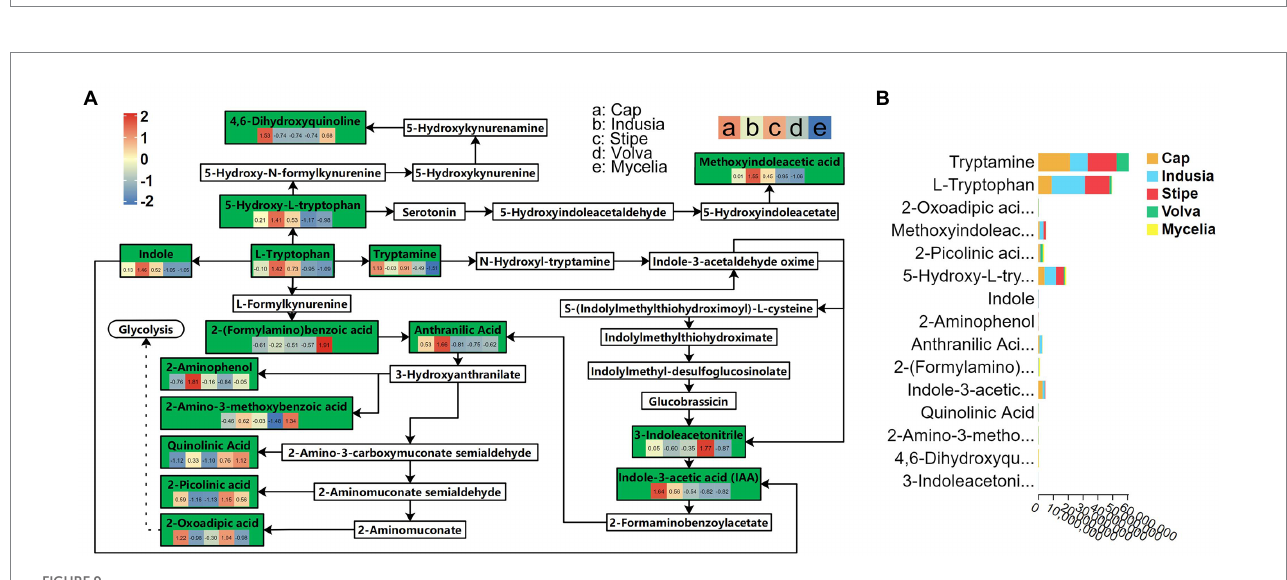
FIGURE 9 Tryptophan metabolism pathway (ko00380) in five DI tissues. (A) The boxes represent metabolites involved in the pathway. Green boxes represent the detected metabolites, and white boxes represent the undetected metabolites. The color (red to blue) key in the green boxes represents the relative abundance of the metabolite in different tissues (Evaluated by z -value, the key is shown in the upper left corner). The alphabets used for the tissues are shown in the upper right corner. The solid arrows represent the metabolic process, and the dashed arrows leading to glycolysis represent the processes in which some metabolites are ignored; metabolites eventually end up in glycolysis. (B) Relative abundance of metabolites of the ko00380 pathway in different DI tissues. The abscissa represents the peak area unit of the metabolite, and the ordinate represents different metabolites. Different colors in the stack diagram indicate different tissues shown in the legend in the upper right